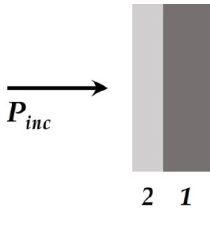
Figure 33. Scheme of the formation of a two-layer combination of samples: (1) base sample Co-03 and (2) additional sample.